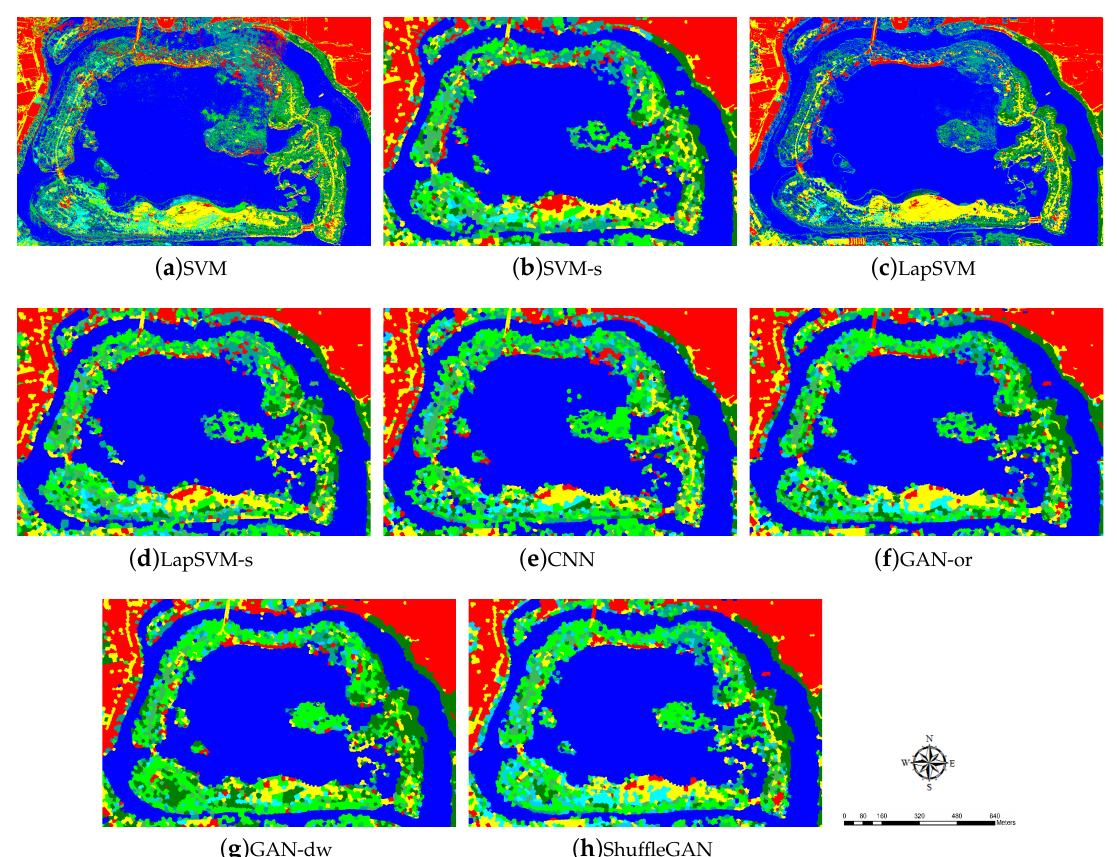
Figure 9. Classification maps of the Haizhu Lake wetland data obtained by ( a ) Support Vector Machine (SVM), ( b ) SVM-s, ( c ) LapSVM, ( d ) LapSVM-s, ( e ) Convolutional Neural Network (CNN), ( f ) GAN-or, ( g ) GAN-dw and ( h )